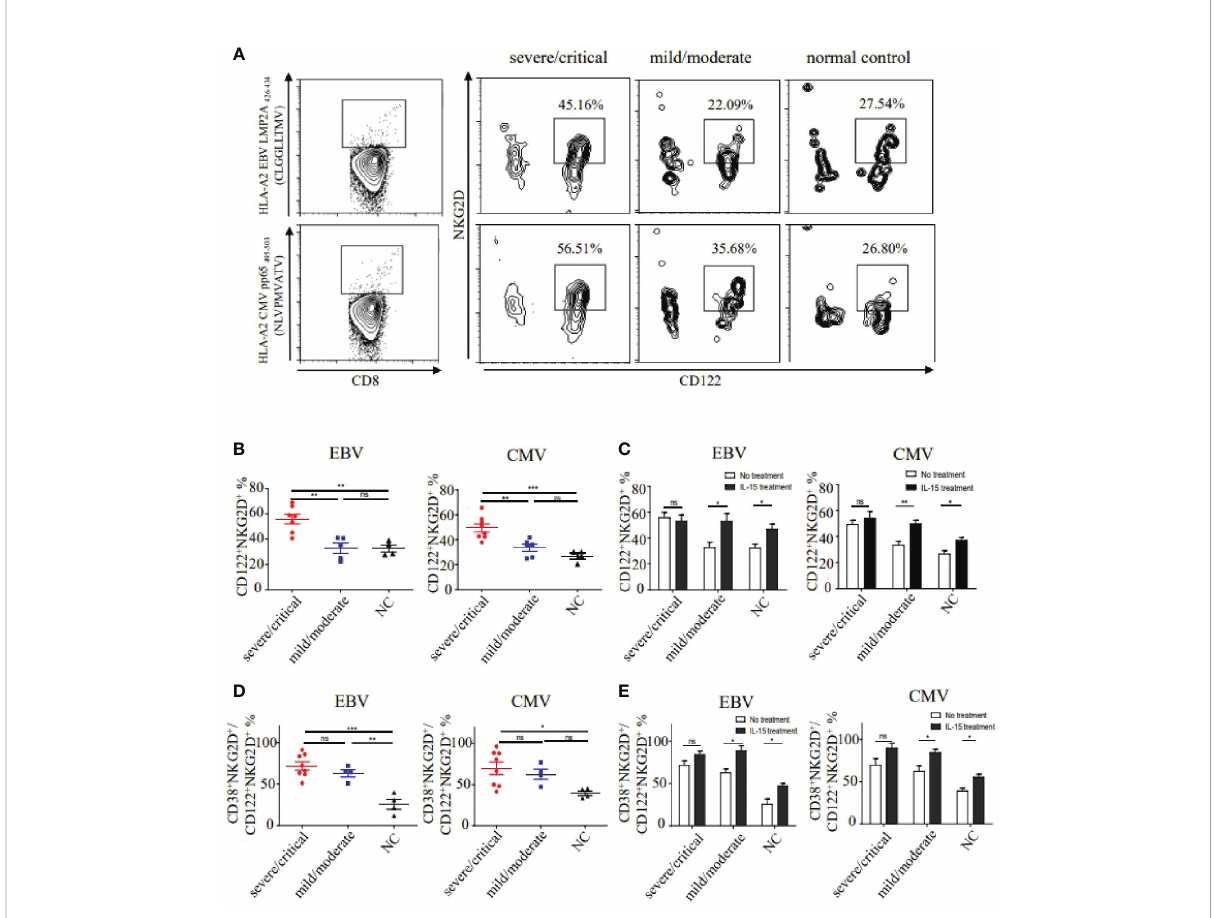
FIGURE 4 The frequencies and activation status of CD122 + NKG2D + EBV or CMV p/HLA-A*02 tetramer + CD8 + T cells in different severities of HFRS. (A) Representative fl ow cytometry of CD122 + NKG2D + phenotypes on EBV or CMV p/HLA-A*02 tetramer + CD8 + T cells in the severe/critical and mild/moderate patients. (B) Comparison of the frequencies of CD122 + NKG2D + EBV (n severe/critical =7, n mild/moderate =5) or CMV (n severe/critical =8, n mild/moderate =6) p/HLA-A*02 tetramer + CD8 + T cells between different severities of HFRS. (C) Comparison of the frequencies of CD122 + NKG2D + EBV or CMV p/HLA-A*02 tetramer + CD8 + T cells in severe/critical and mild/moderate of HFRS with or without IL-15 treatment. (D) Comparison of the frequencies of CD38 + HLA-DR + CD122 + NKG2D + EBV (n severe/critical =8, n mild/moderate =4) or CMV (n severe/critical =8, n mild/ + CD8 + T cells in the severe/critical and mild/moderate of HFRS. (E) Comparison of the frequencies of moderate =4) p/HLA-A*02 tetramer CD38 + HLA-DR + CD122 + NKG2D + EBV or CMV p/HLA-A*02 tetramer + CD8 + T cells of HFRS with or without IL-15 treatment. *p<0.05;